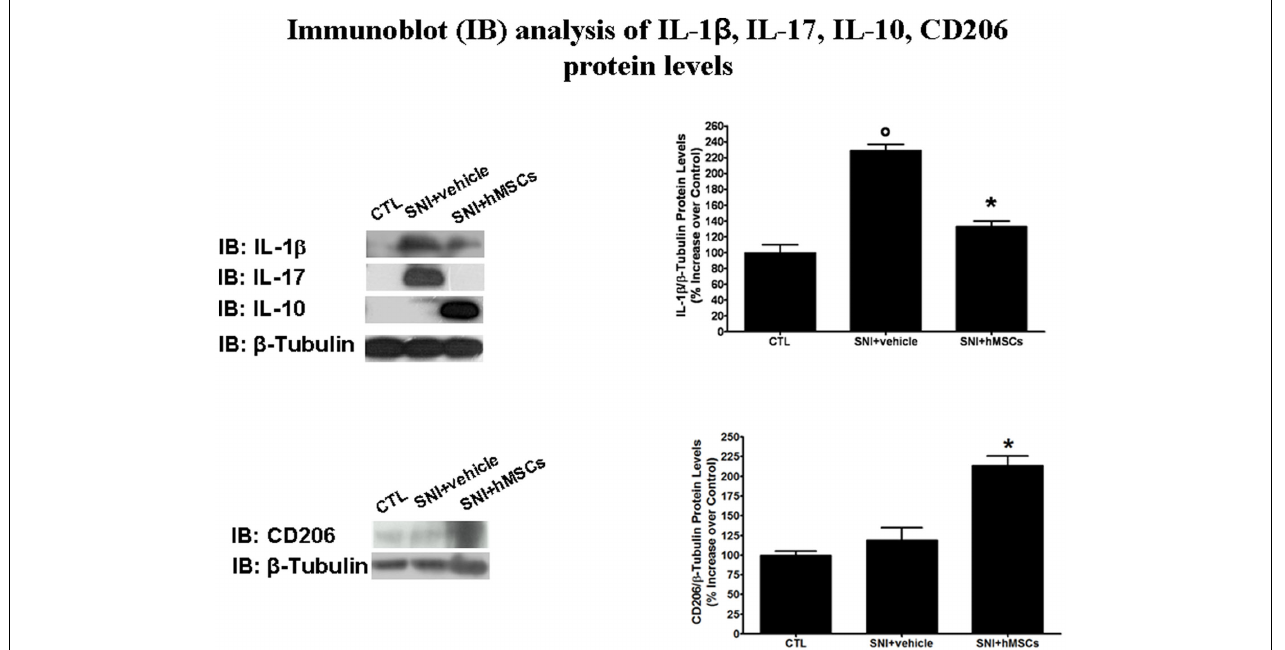
treatment (on day 4 after SNI surgery) reduced the protein levels of IL- 1 β interleukin in hMSC-treated 30days-neuropathic mice (SNI + hMSCs) respect to vehicle treated 30days-neuropathic mice (SNI + vehicle). ANOVA, followed by Student–Neuman–Keuls post hoc test, was used to determine the statistical significance among groups. * p < 0.01 was considered statistically significant. Lower graph shows CD206/ β -tubulin normalized values as obtained by immunoblot analysis. Human MSC treatment (on day 4 after SNI surgery) increased the protein levels of activated anti-inflammatory macrophage marker CD206 in hMSC-treated 30days-neuropathic mice (SNI + hMSCs) respect to vehicle treated 30days-neuropathic mice (SNI + vehicle). ANOVA, followed by Student–Neuman–Keuls post hoc test, was used to determine the statistical significance among groups. * p < 0.01 was considered statistically